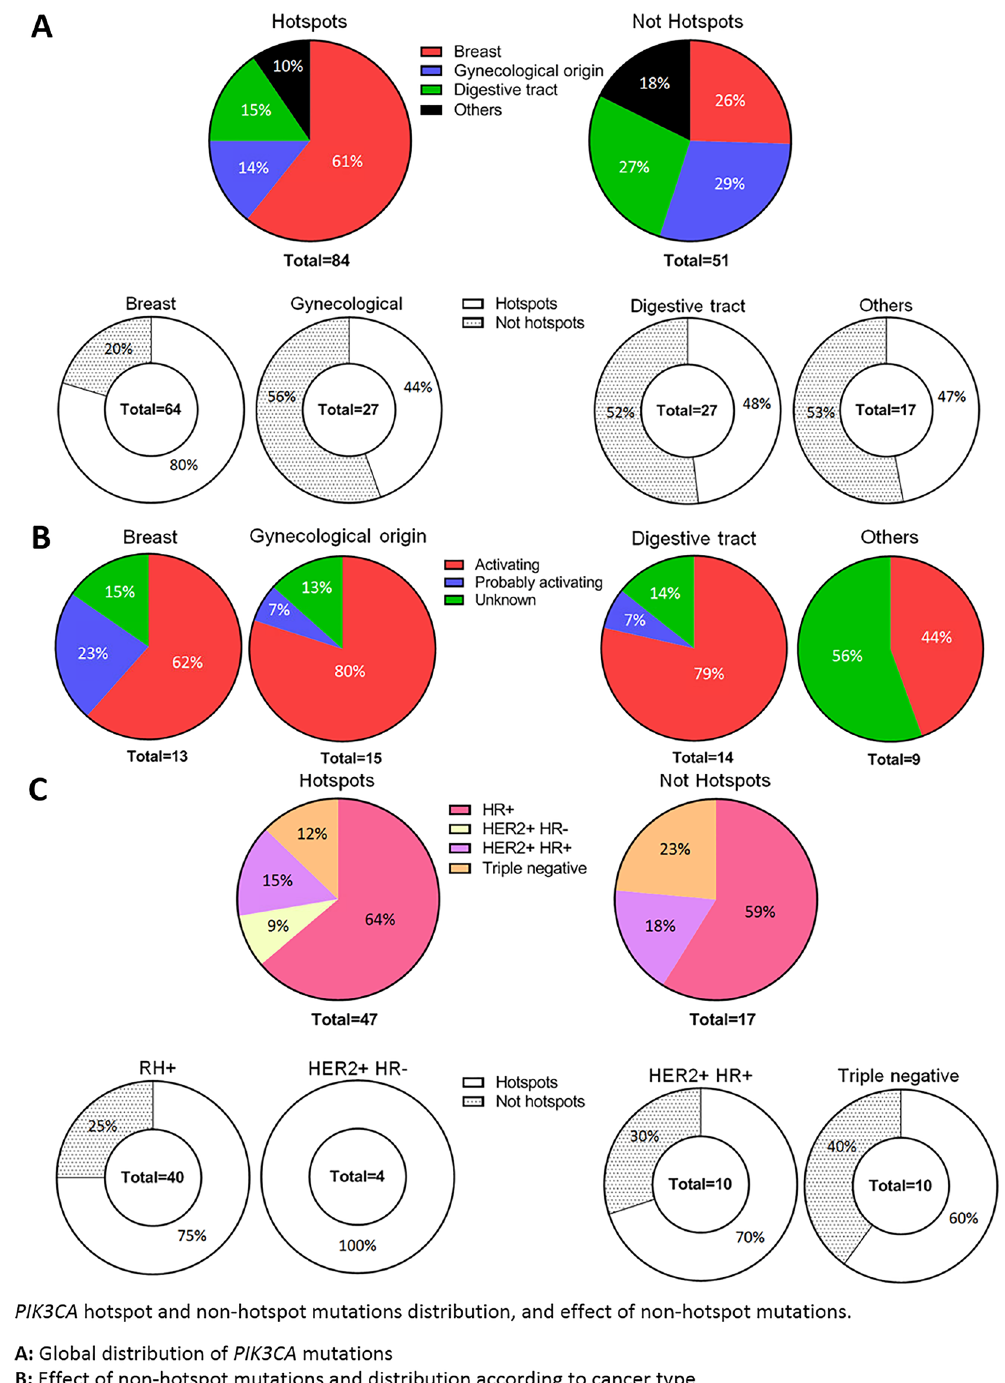
Figure 4. PIK3CA hotspot and non-hotspot mutations distribution, and effect of non-hotspot mutations.( A ) Global distribution of PIK3CA mutations.( B ) Effect of non-hotspot mutations and distribution according to cancer type.( C ) PIK3CA mutations distribution in breast